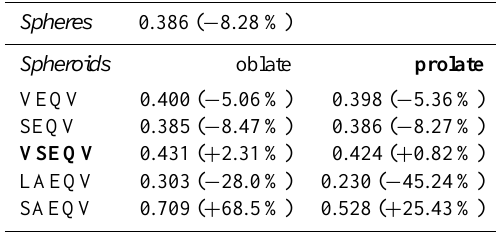
Table 1. Values of the optical depth simulated at 500 nm wave- length for the cases of size equivalence and particle shape of Fig. 8 and representative for the mineral dust observed on 19 May 2006 over OZT site about noon. The values in parentheses mean devia- tions to the respective mean value of 0 . 421 ± 0 . 005 measured via a sun photometer by Tesche et al.